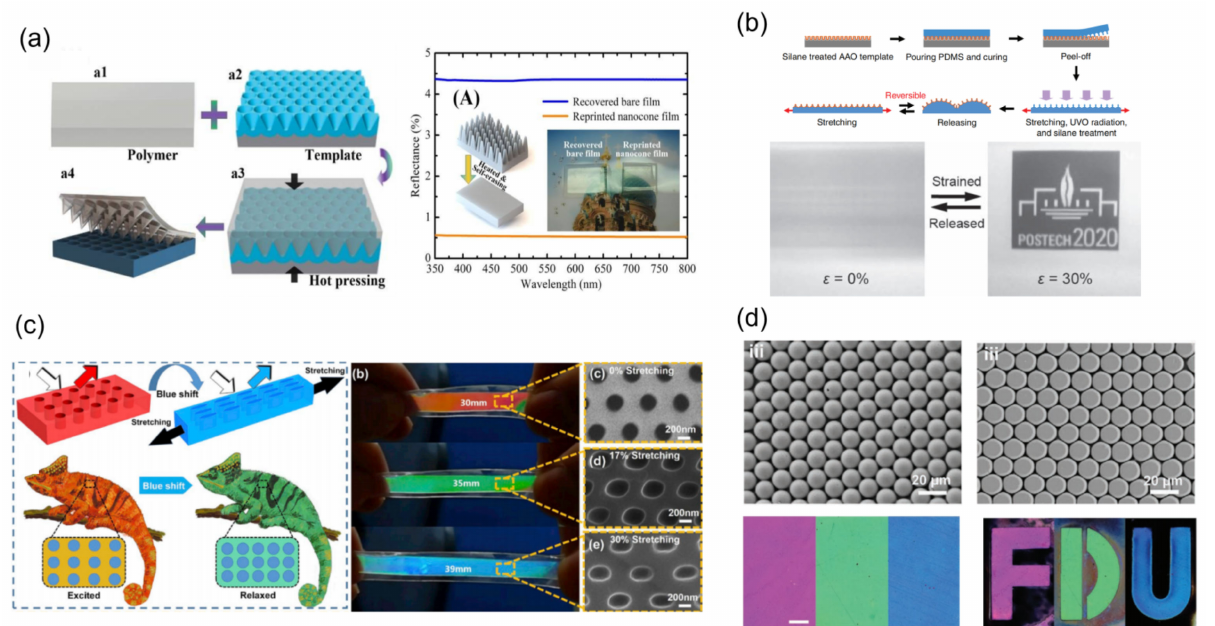
Figure 1. The strategies of mechanoresponsive smart windows based on nanoarrays: ( a ) nanocone [20] Copyright 2018, MDPI (Basel, Switzerland), ( b ) nanopillar [21] Copyright 2010, John Wiley and Sons (Hoboken, NJ, USA), ( c ) nanoholes [22] Copyright 2019, Elsevier (Amsterdam, The Netherlands), ( d ) nanospheres [23] Copyright 2021, John Wiley and